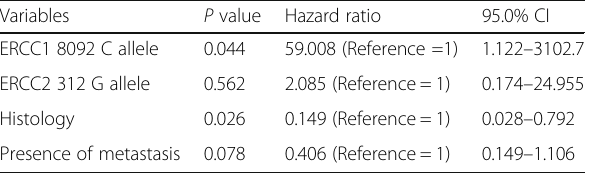
Table 8 Factors associated with EFS rate